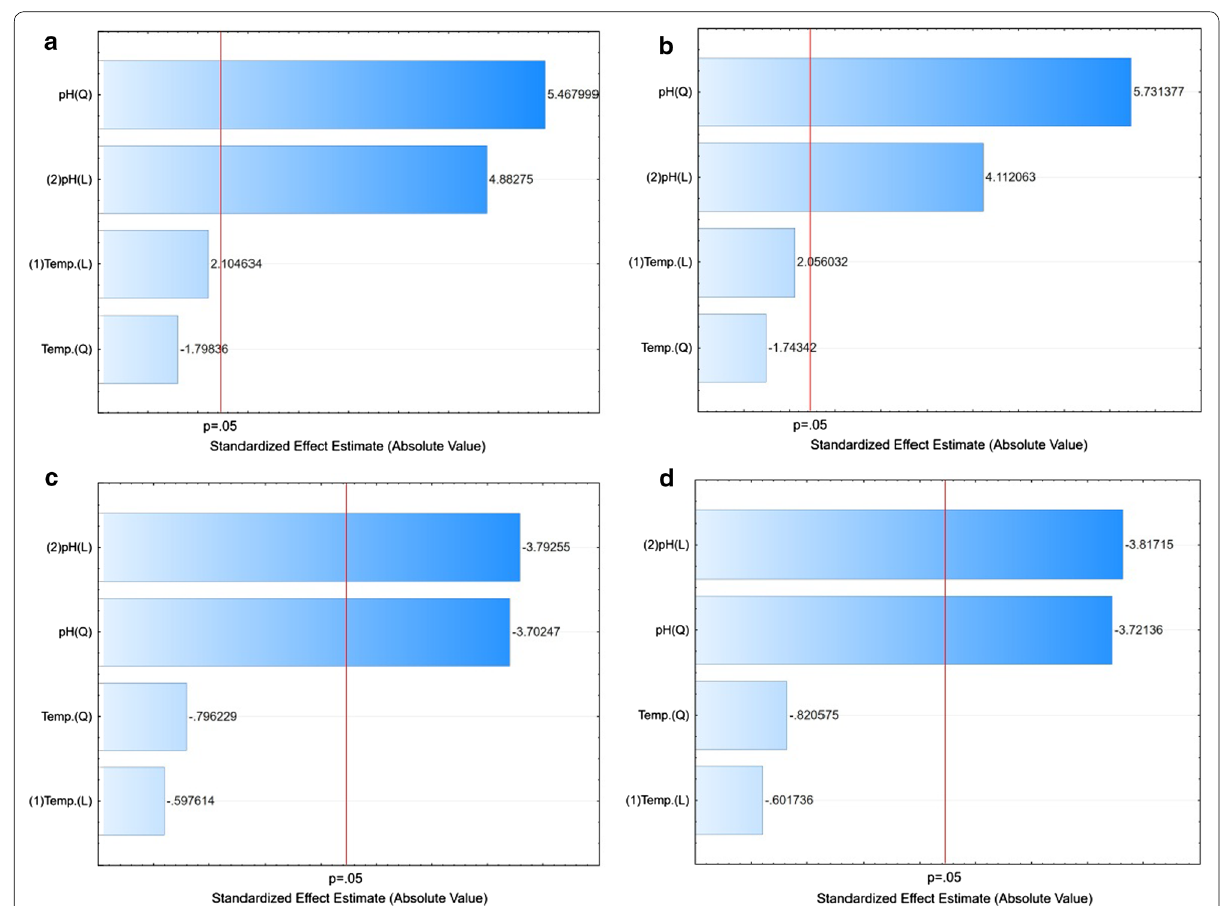
Fig. 3 Pareto chart showing the effect of different culture parameters (variables) on protein-enriched biomass from the YPD medium based on the observation of the fractional factorial design. a TN ( Y. lipolytica ATCC 9793); b TP ( Y. lipolytica ATCC 9793); c TN ( Y. lipolytica A-101); d TP ( Y. lipolytica A-101); TN, total nitrogen; TP, total